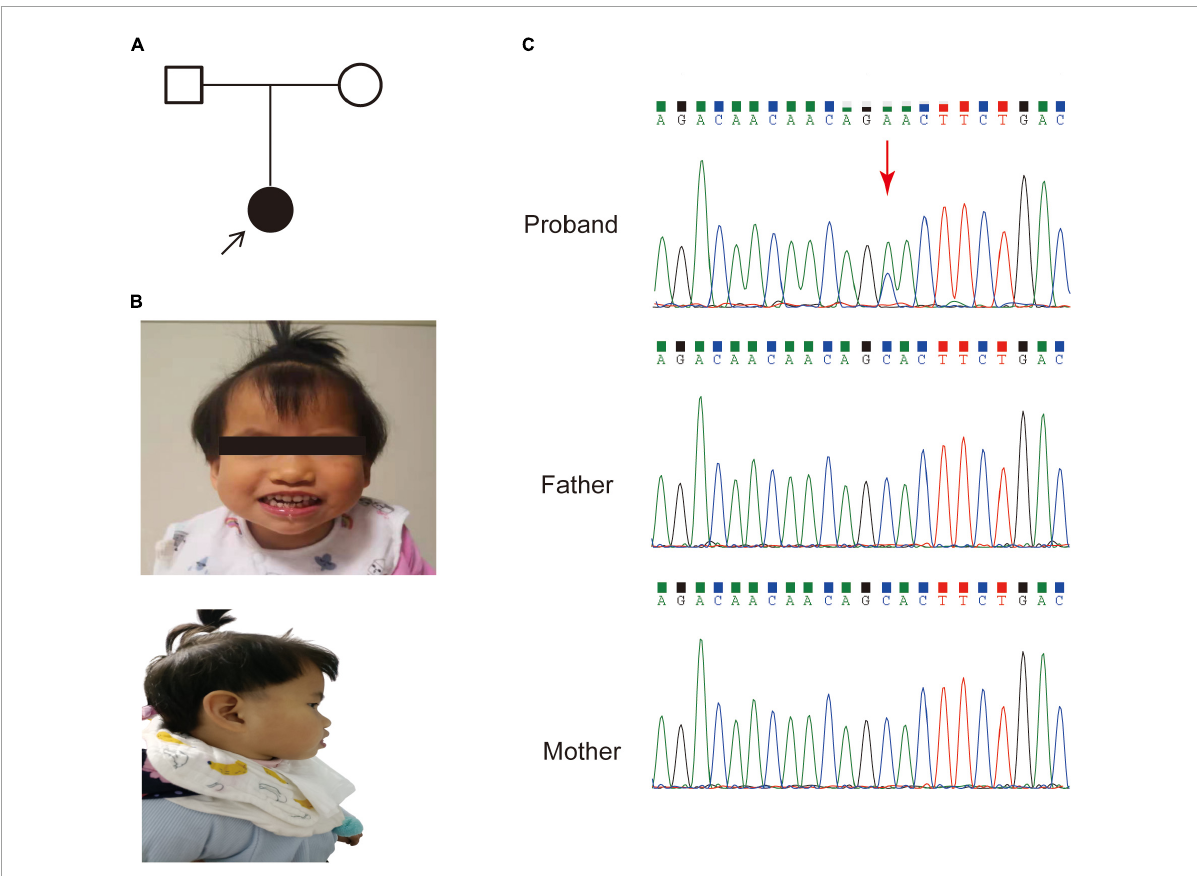
FIGURE1 The pedigree and clinical features of the patient. (A) Family pedigree of the patient in this study. (B) Dysmorphic features, including a prominent forehead, midface hypoplasia and protruding tongue. (C) Sanger sequencing of the SETBP1 gene (c.2631C > A; p. S877R) variant in genomic DNA from the family, confirming that the variant of the SETBP1 gene identified in the patient is de novo